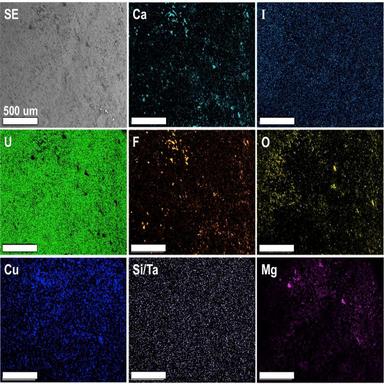
Large area image and elemental X-ray maps (10 kV scan) of the metal surface.